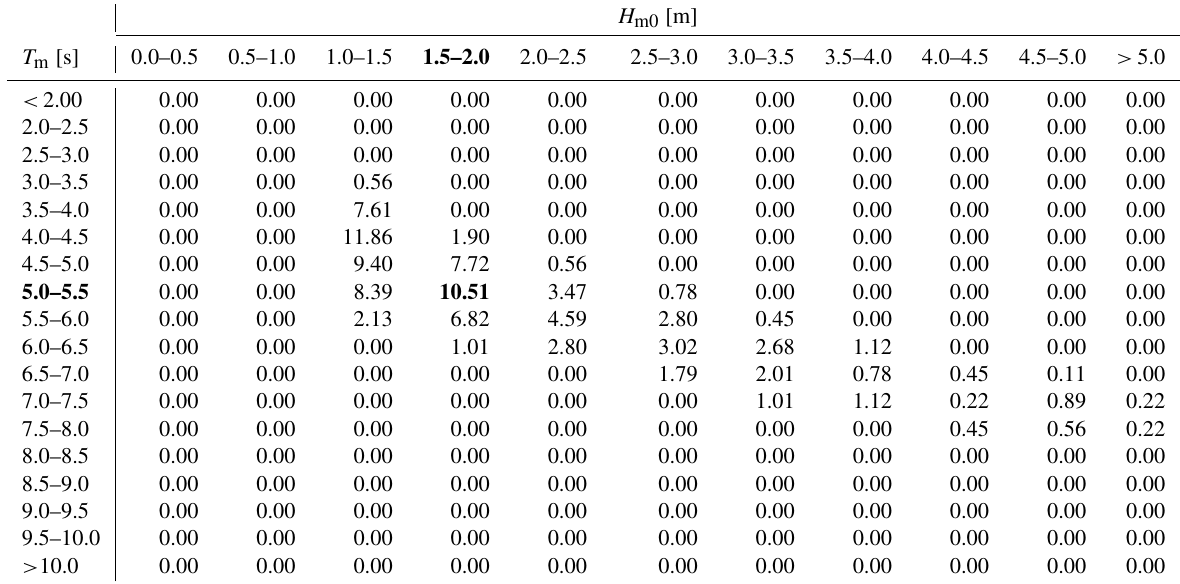
Table 2. Frequency (%) for classes of H m0 and T m in 2012–2013 (only referring to sector 105–135 ◦ ). The most probable classes are reported in bold.